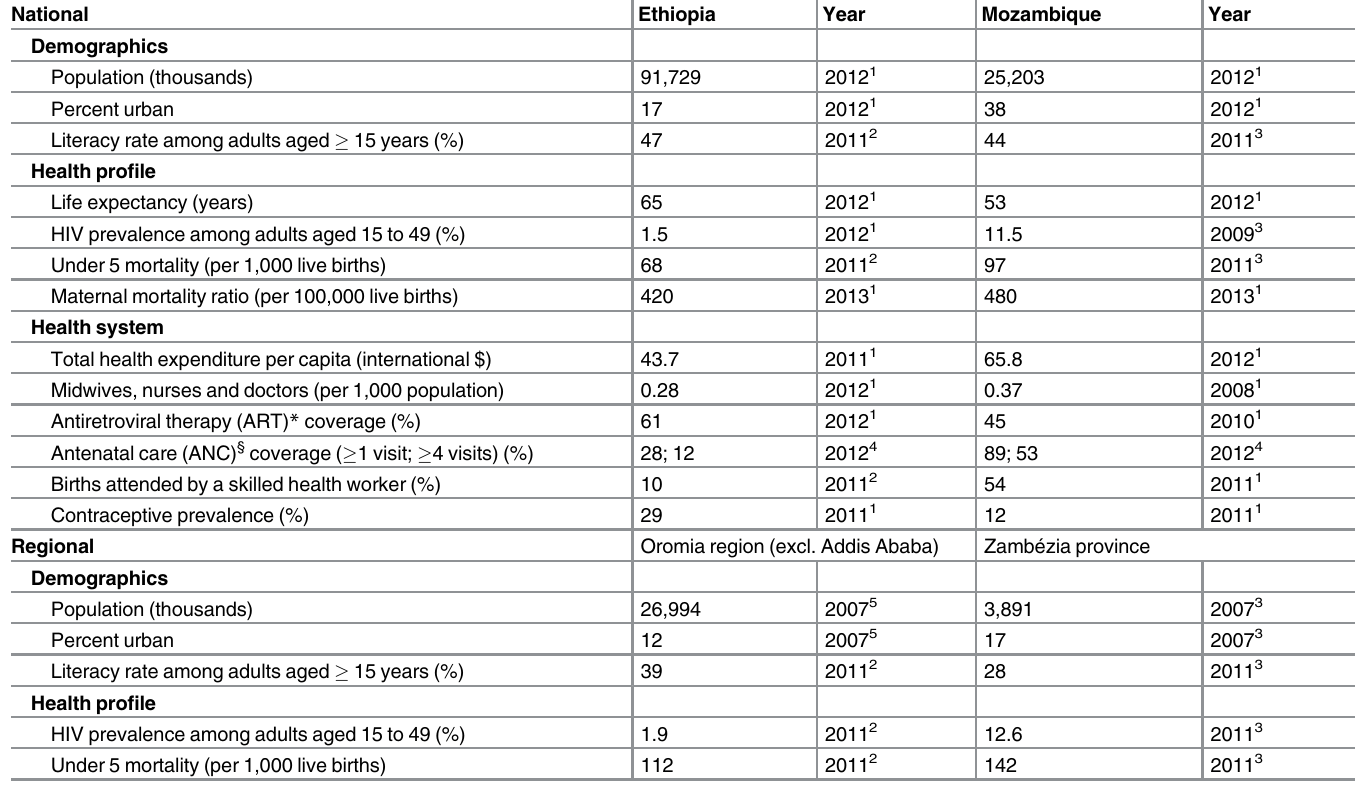
Table 1. Demographic and health profiles of study countries and